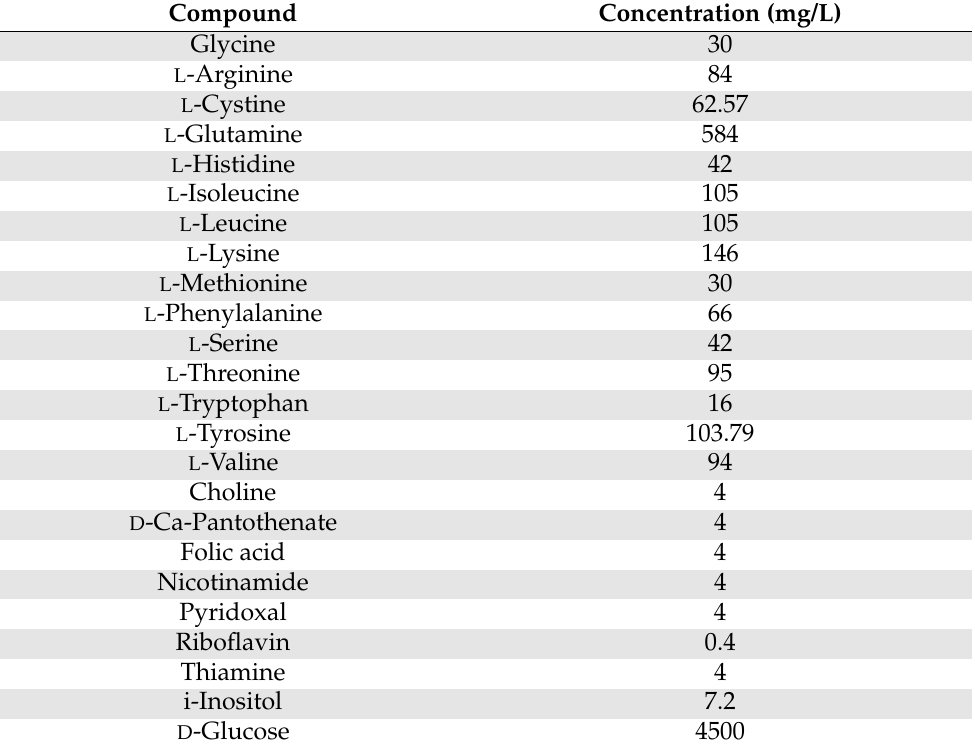
Table 2. Absolute concentrations from the Dulbecco’s modified Eagle’s medium (DMEM)